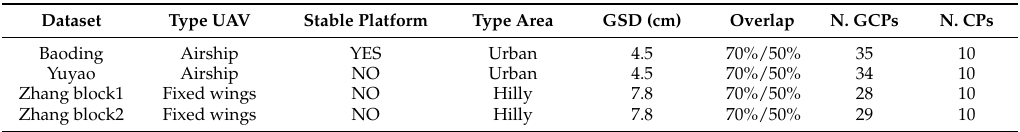
Figure 8. Schematic drawings of the experimental datasets. ( a ) Zhang Jiakou block1; ( b ) Zhang Jiakou block2. Table 4. Statistical information of the experimental datasets.